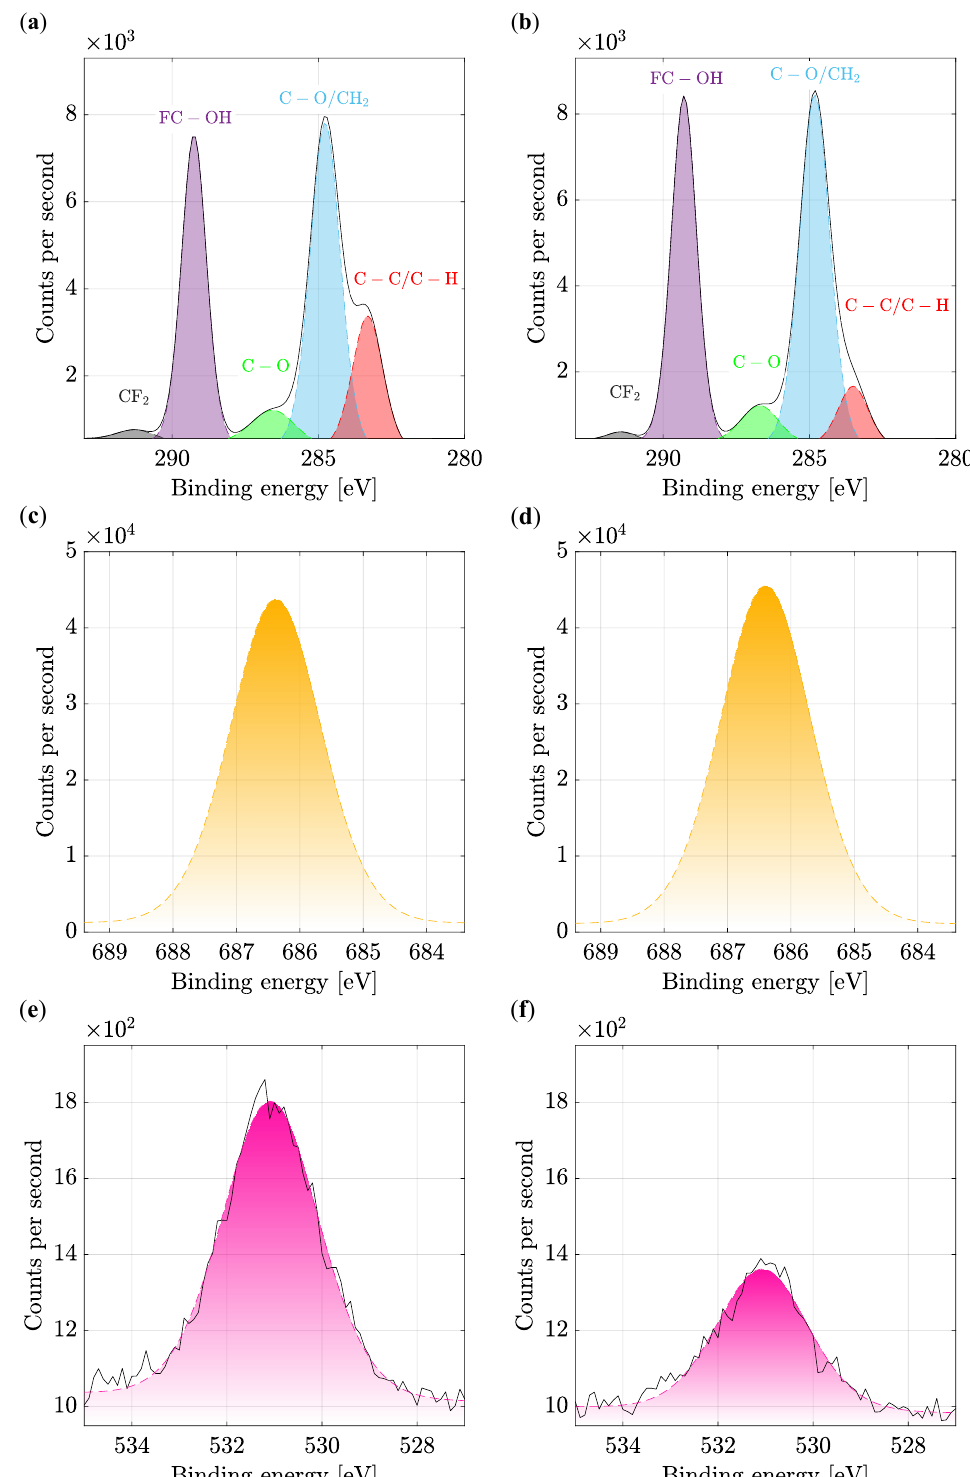
Figure 8. XPS spectra in ( a , b ) of the C1s high-resolution energy band’s expressed by an envelope, fitted and divided into individual peaks of certain bonds in the material [44]. A more substantial C − C/C − H binding (red peak) is recognised on the fiber produced at ( a ) 300rpm compared to the fiber produced at ( b ) 2000rpm. High-resolution energy band of F1s orbital electron is in ( c , d ). High-resolution energy band of O1s orbital electron is shown in ( e , f ). Please note that plots in ( a , c ), and ( e ) are depicted for PVDF fibers electrospun at 300rpm collector speed, whereas plots in ( b , d ), and ( f ) are shown for nanofibers at 2000rpm collector